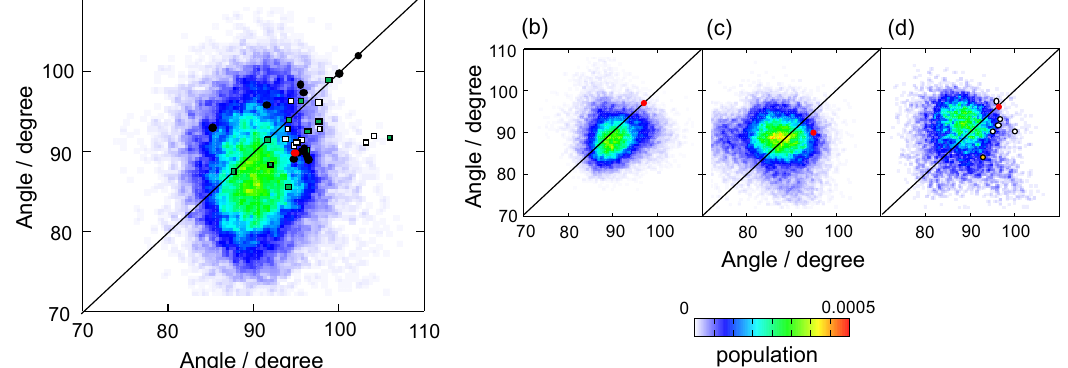
Figure 3. Distribution of intra-chain domain-orientation angles between C H 2 and C H 3 for the ensemble models of IgG1-Fc and various crystal structures of IgG1-Fc. The angles between the C H 2 and C H 3 domains of chain A and chain B were plotted on the X axis and Y axis, respectively, for the ensemble models derived from MD simulations starting from the initial structures based on ( a ) asymmetric crystal structure (3AVE) supplemented with the crystallographically unobserved N- and C-terminal segments, ( b ) symmetric crystal structure (5IW3) supplemented with crystallographically unobserved N- and C-terminal segments, ( c ) crystallographically observed parts of 3AVE, and ( d ) 5WI3 supplemented with the crystallographically unobserved N- and C-terminal segments with deletion of the N-glycans. In A, B, and C, the N-glycans of each initial structure were modeled to have the core fucose residue and the terminal galactose residue of the α 1-6Man branch. The angles observed in the crystal structures are represented as circles for uncomplexed Fc structures (red, the starting structures used for the corresponding MD simulations; black, Fc with native N-glycans; white, Fc with enzymatically trimmed N-glycans; yellow, aglycosylated Fc), rectangles for complexed Fc structures (white, complex with sFc γ Rs; green, complex with other ligands).